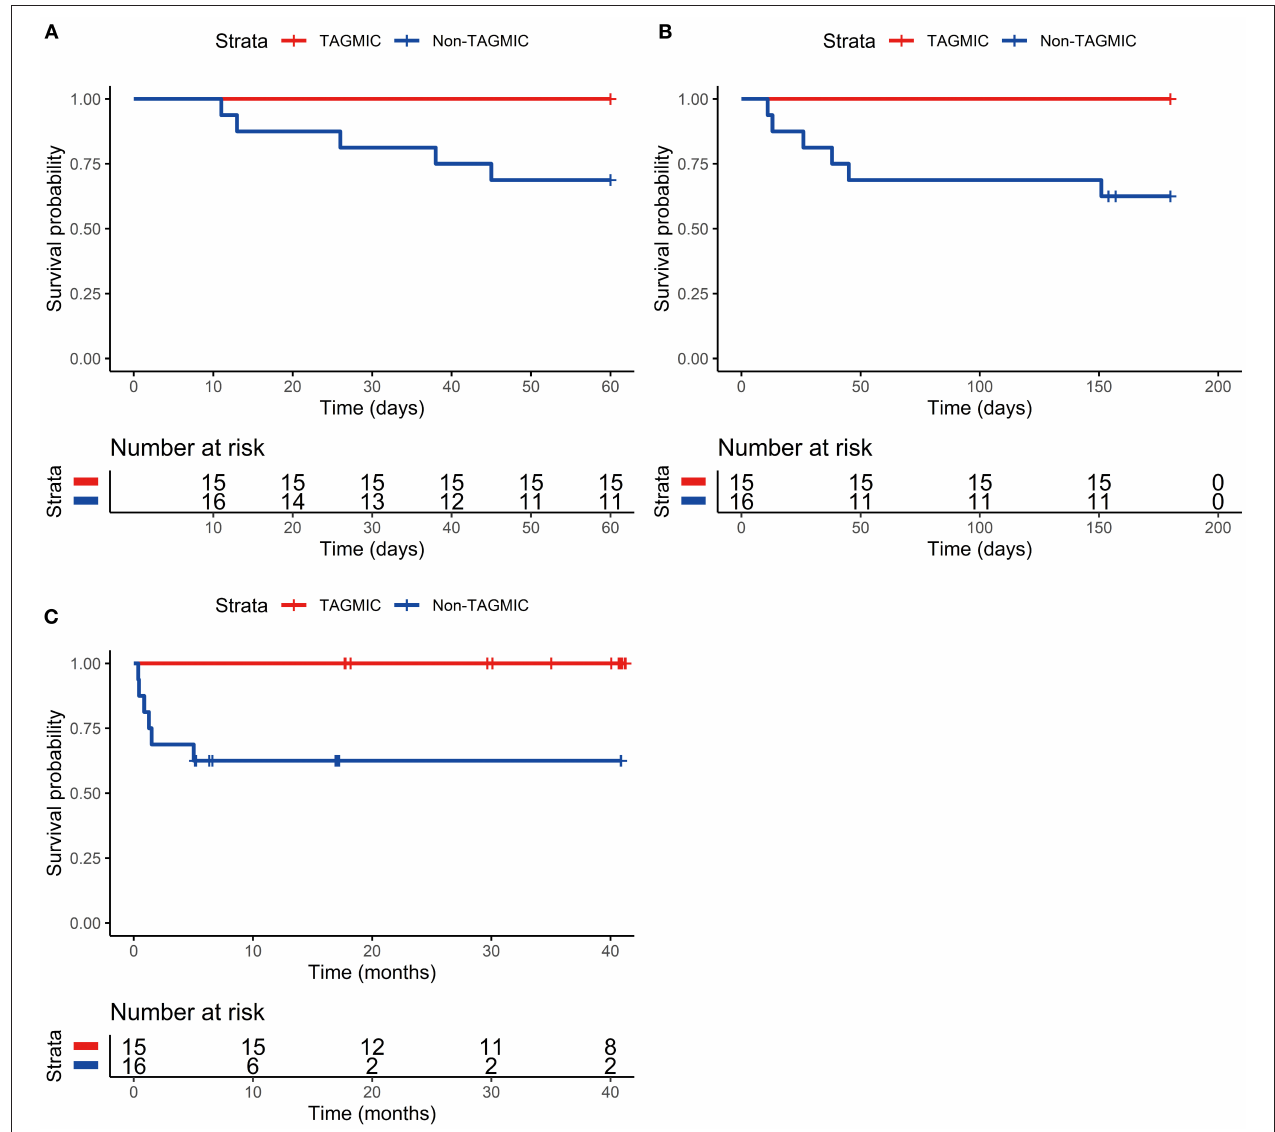
FIGURE 3 | Comparison of 60-day, 6-month, and overall survival curves between TAGMIC group and Non-TAGMIC group. (A) Comparison of 60-day survival curves between TAGMIC group and Non-TAGMIC group. (B) Comparison of 6-month survival curves between TAGMIC group and Non-TAGMIC group. (C) Comparison of overall survival curves between TAGMIC group and Non-TAGMIC group. (C) Shows that due to the different dates of onset of patients, as of the end time of our follow-up (January 2020), the follow-up period of patients ranges from several weeks to several years. At the 10-month follow-up, 6 patients in the Non-TAGMIC group died (the part of the curve descending), and 4 patients were shorter than 10 months by the end of January 2020 (4 short vertical lines, 2 of which are almost overlapped due to the close distance.) Therefore, 6(16-6-4) patients over 10 months, need to continue to extend the display on the curve. There were no deaths in the TAGMIC group and no decline in the survival curve. For example, in the TAGMIC group, there are 3 patients with a follow-up period of fewer than 20 months (3 short vertical lines), and 12(15-3) patients with a follow-up period of more than 20 months, which need to be extended on the curve. TAGMIC: ganciclovir, methylprednisolone, and immunoglobulin